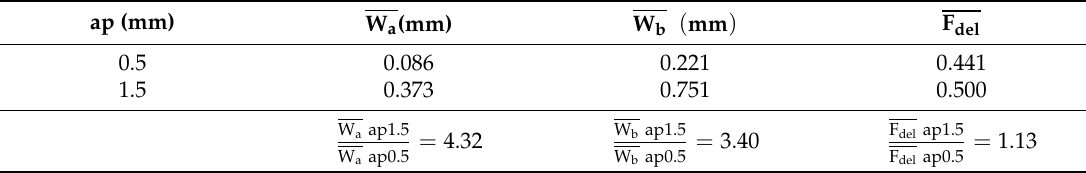
Table 7. Comparison of experiments with di ff erent depth of